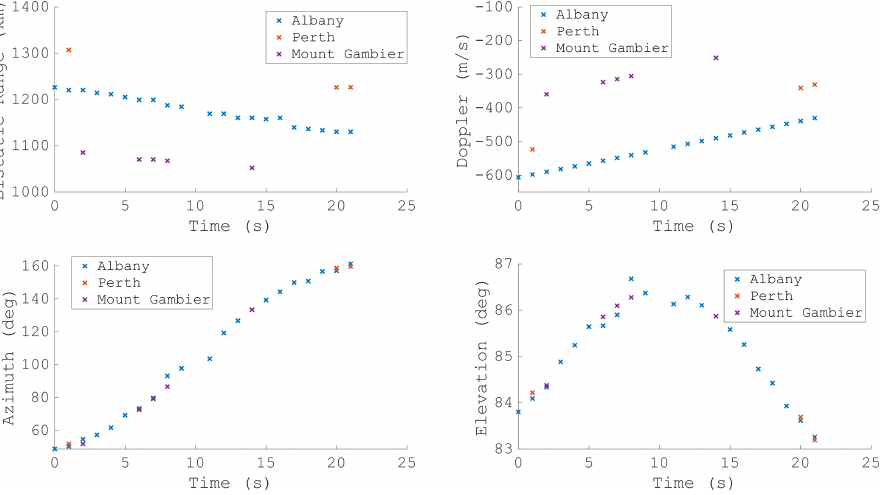
Figure 20. The four measurement parameters from detections of OPS 5721 detected using FM transmitters in Albany, Perth and Mount Gambier.